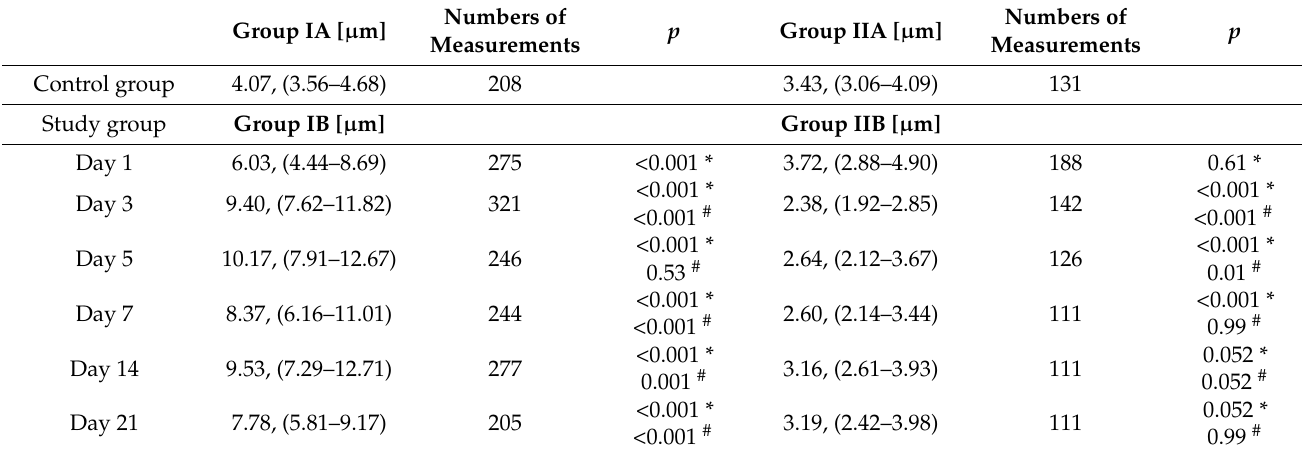
Table 1. Summary of the morphometry of sinusoidal capillaries of the liver of adult rats and juvenile rats.